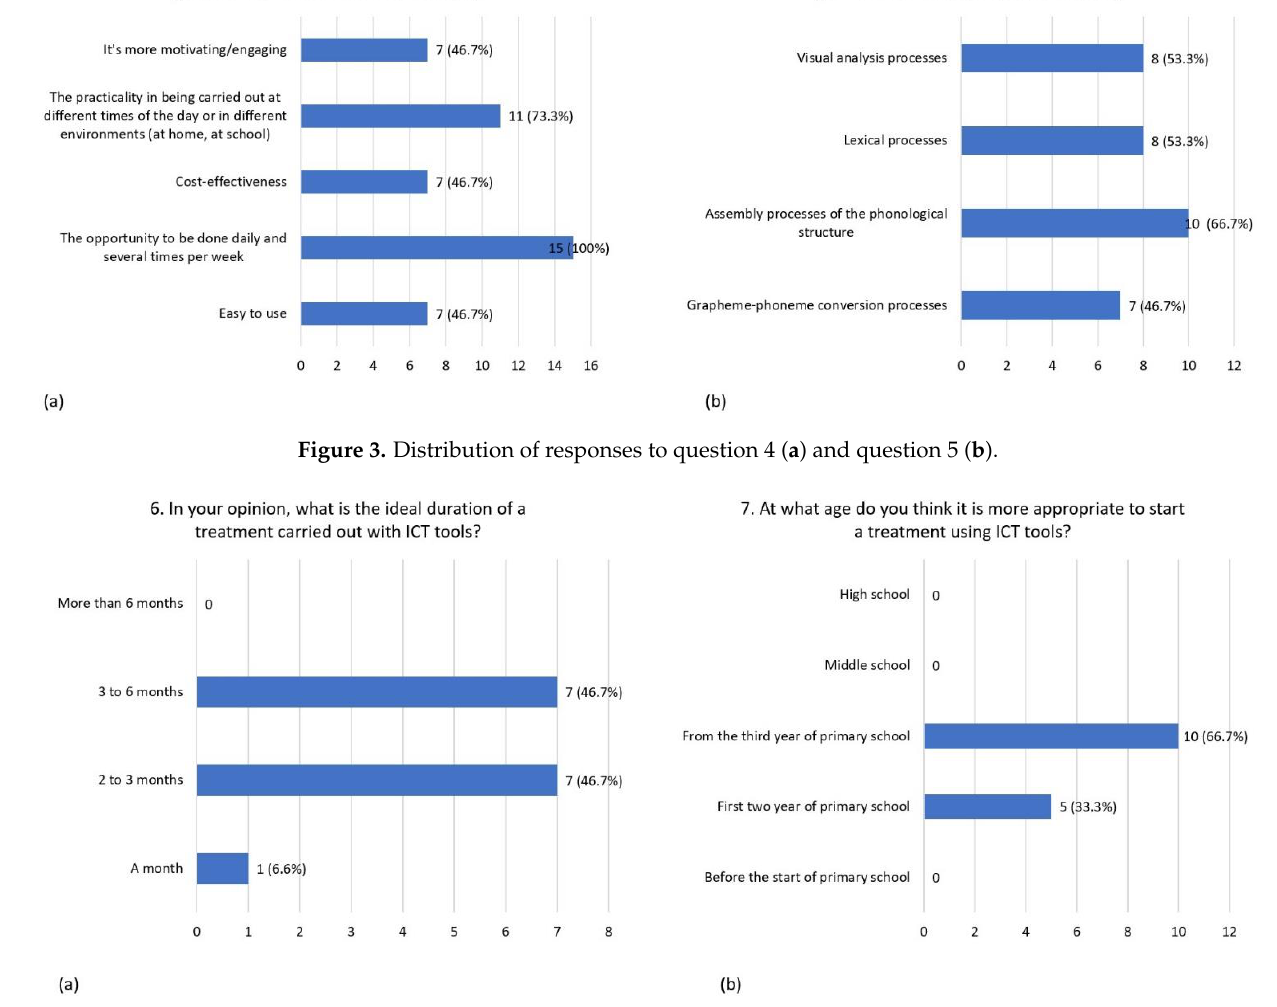
Figure 4. Distribution of responses to question 6 ( a ) and question 7 ( b